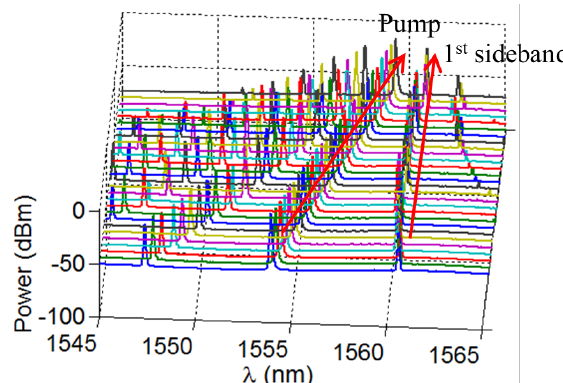
Figure 8: Experimental comb spectra generated due to mode cou- pling induced modulational instability. The pump laser pumps dif- ferent resonances of mode 1 in the region marked with a green box in Figure 7C. One comb sideband is always pinned at a position close to the mode-crossing wavelength. Adapted from Ref.